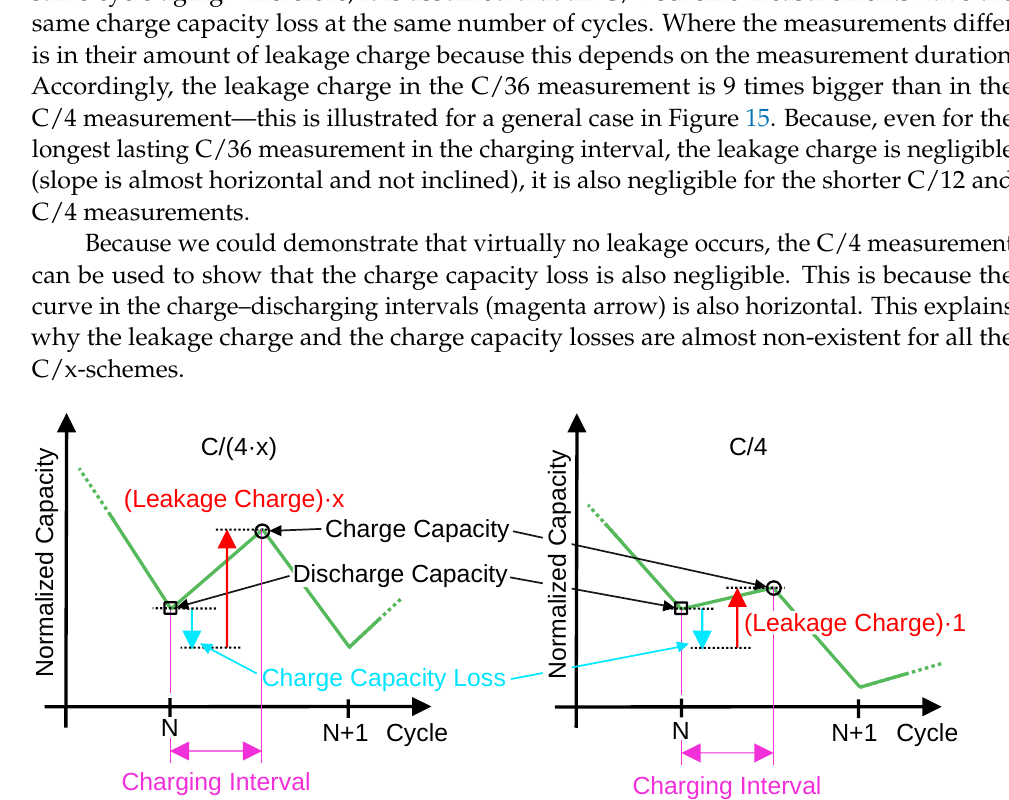
Figure 15. Here, two charging cycles of the C/x-scheme are compared in terms of leakage charge and charge capacity loss. For different C/x-cycling-schemes, the degradation during charging is the same for different cycling rates at the same cycle. However, the leakage charge increases with the measurement